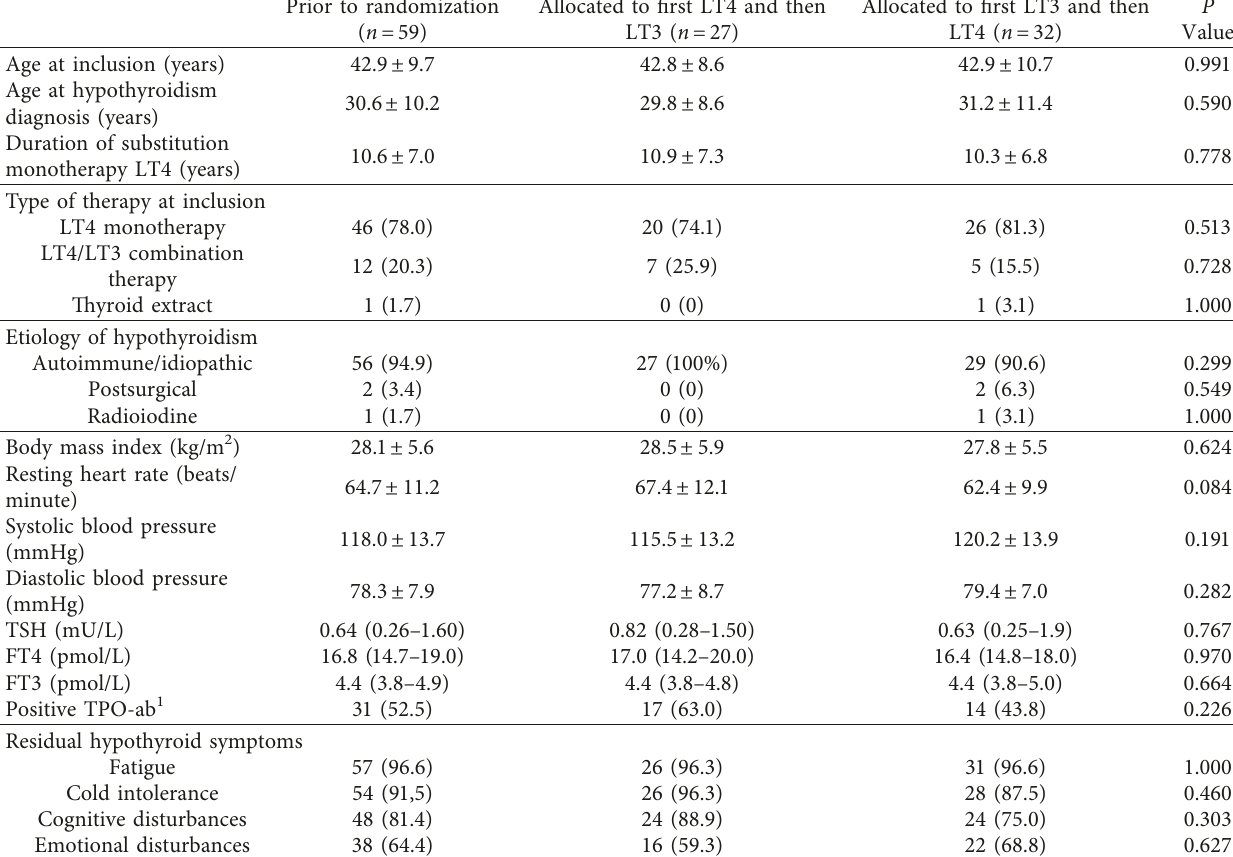
Table 1: Baseline